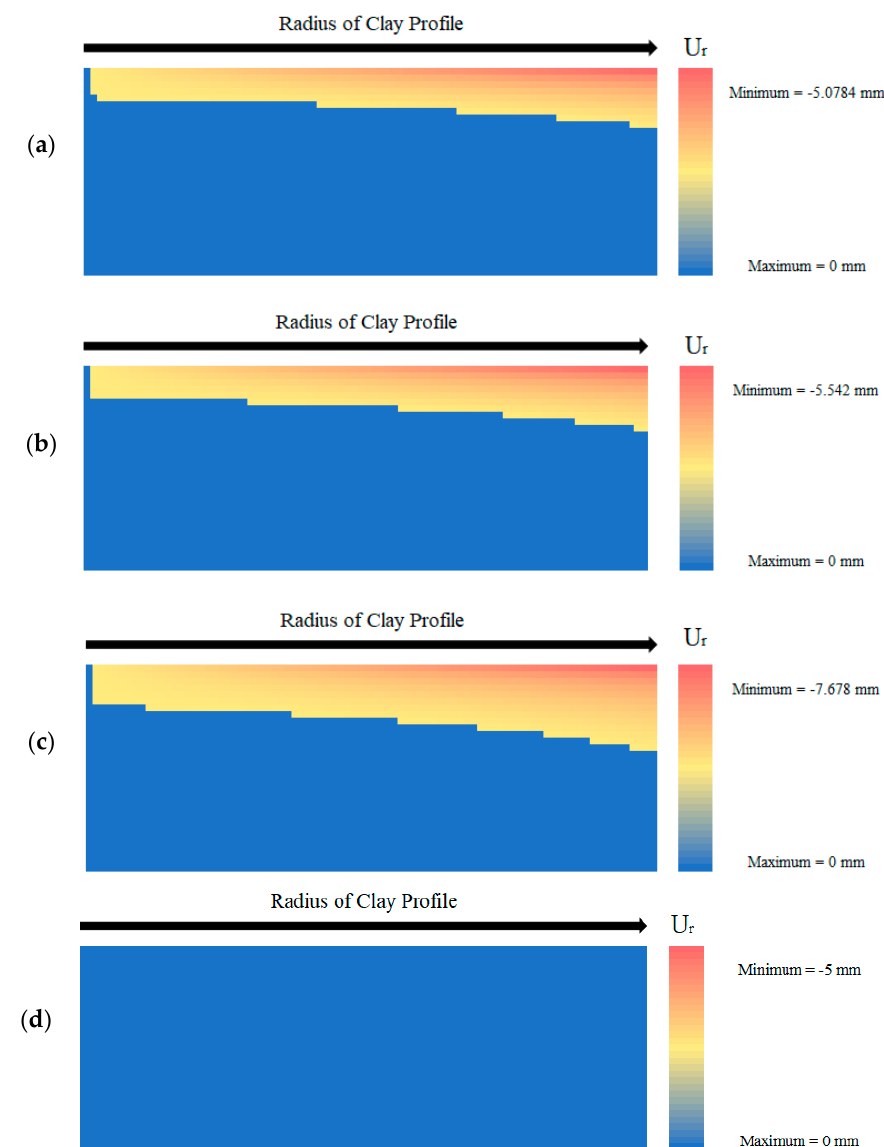
Figure 14. Displacement across the clay profile at the end of the analysis for the ( a ) untreated, ( b ) 0.5% fiber-treated, ( c ) 2% fiber-treated, and ( d ) xanthan-gum-treated soil.